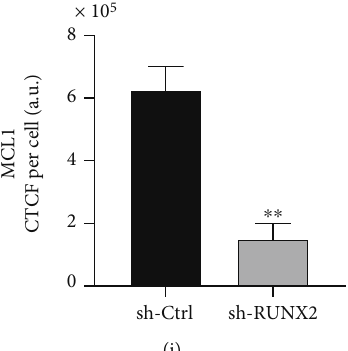
Figure 4: Knockdown of RUNX2 a ff ects antiapoptotic marker expression BCL2, BCL-XL, and MCL1. A549 cells were infected with lentiviral particles coding for sh-RNAs against RUNX2 . Antiapoptotic gene expression levels: BCL2 , BCL-XL , and MCL1 . BCL2 (a), BCL- XL (d), and MCL1 (g) mRNA levels were quanti fi ed by RT-qPCR 48 h after infection. Statistical analyses were performed with respect to cells infected with the virus generated with the pLKO.1 empty vector (sh-Ctrl.). ∗ p < 0 : 05 ; ∗∗ p < 0 : 01 (three independent experiments). Protein levels were analyzed with immuno fl uorescence assays. BCL-2 protein expression with nuclear localization (b). BCL-XL protein expression with mitochondrial localization (e). MCL1 pattern of mitochondrial protein expression (h). Total cell fl uorescence (CTCF) of protein was evaluated ( CTCF = integrateddensity − areaof selectedcell × mean fluorescence of background readings ) using the software ImageJ 1.52p (c, f, i).